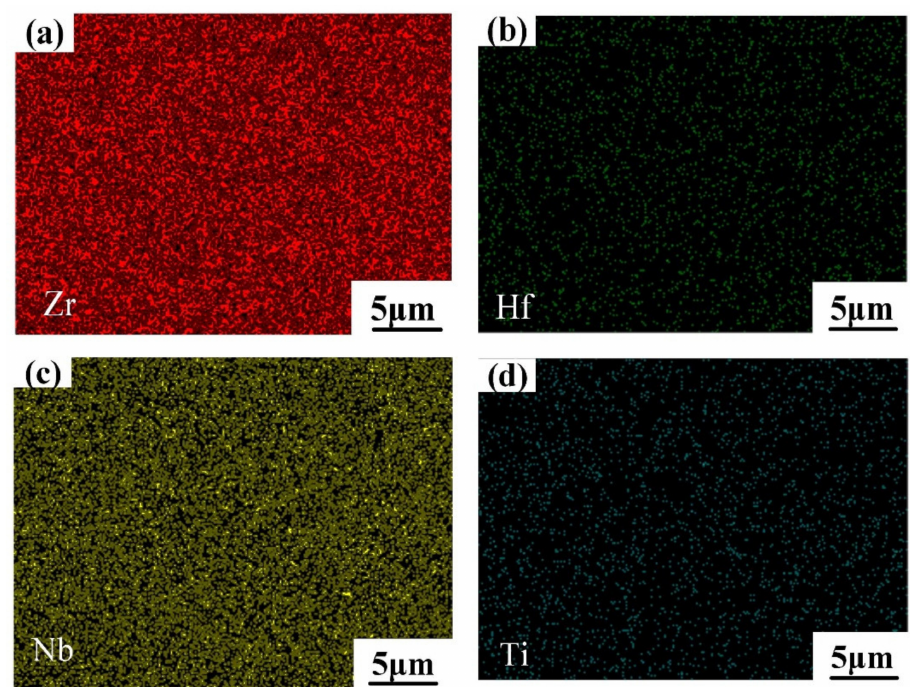
Figure 7. The EDS mapping of Zr ( a ), Hf ( b ), Nb ( c ), and Ti ( d ) of the samples with WC in Figure